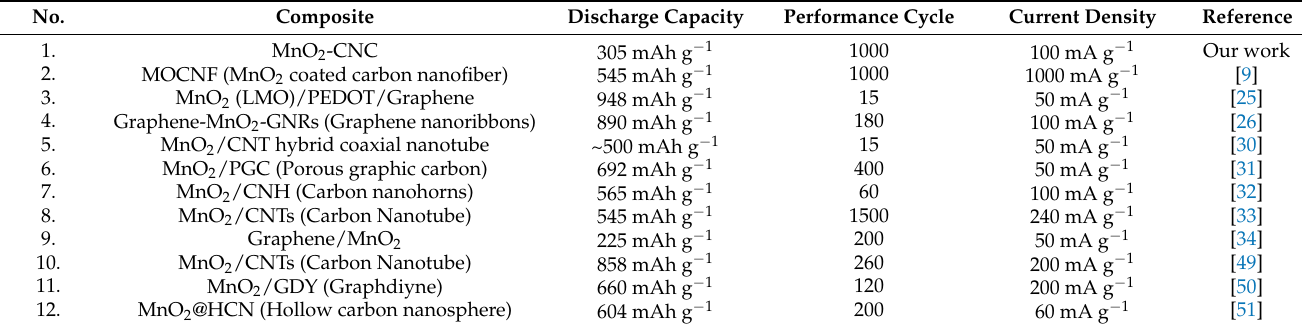
Table 1. Summary of previous works for electrochemical performance employing MnO 2/ electrically conductive carbon material